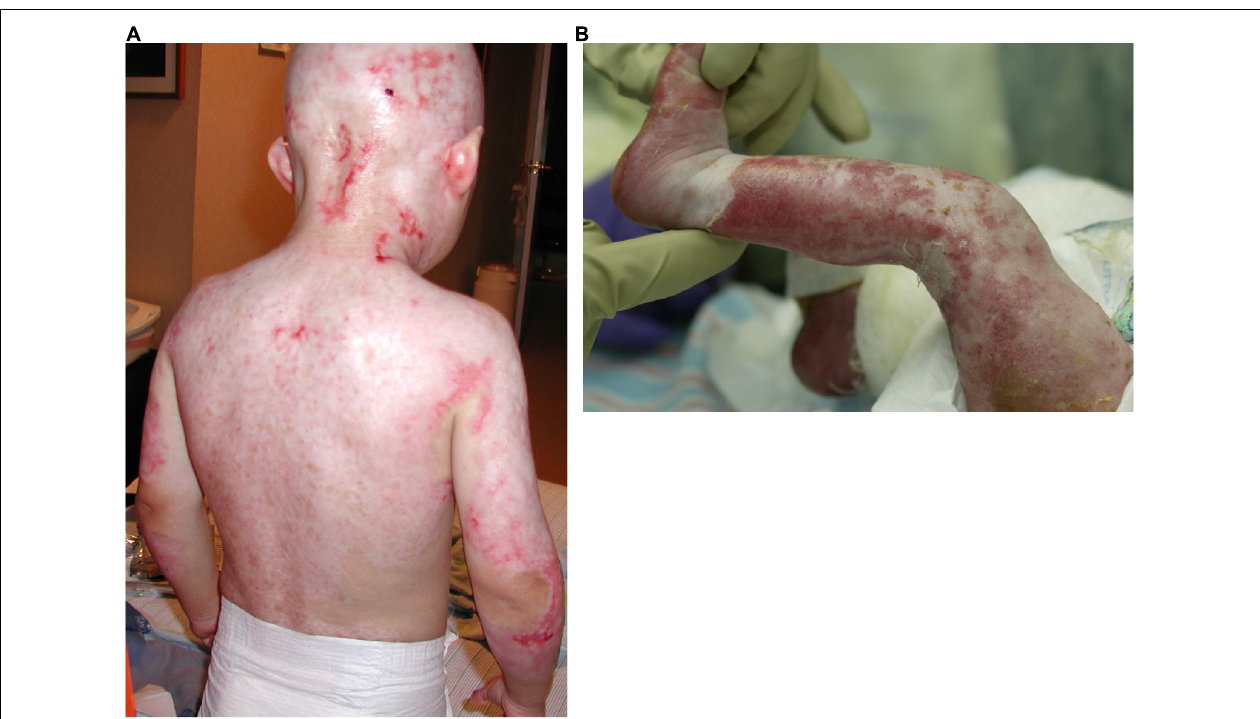
FIGURE 1 | Severe skin erosions on the back (A) and the leg (B) of two AEC